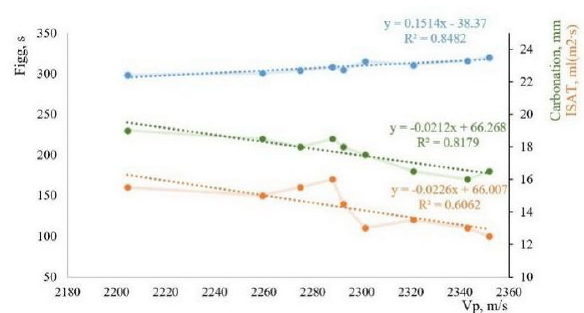
Figure 2: Plots of the dependence of the Figg index and carbonation degree on wave propagation velocity for concrete in the normal state. ( Source: authors’ elaboration )